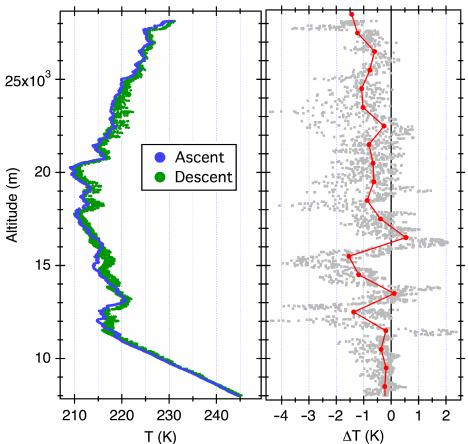
Figure 12. Ascent and descent temperature measurements by an iMet-1-RS radiosonde during a daytime balloon flight over Boul- der (a) . The descent measurements are biased warm and are nois- ier than the ascent measurements due to contamination by the re- versed direction of sensor ventilation during descent. (b) Differ- ences between the ascent and descent temperature measurements (gray) and the median ascent–descent differences within 1km alti- tude bins (red) more clearly show the warm biases and increased noise during descent.